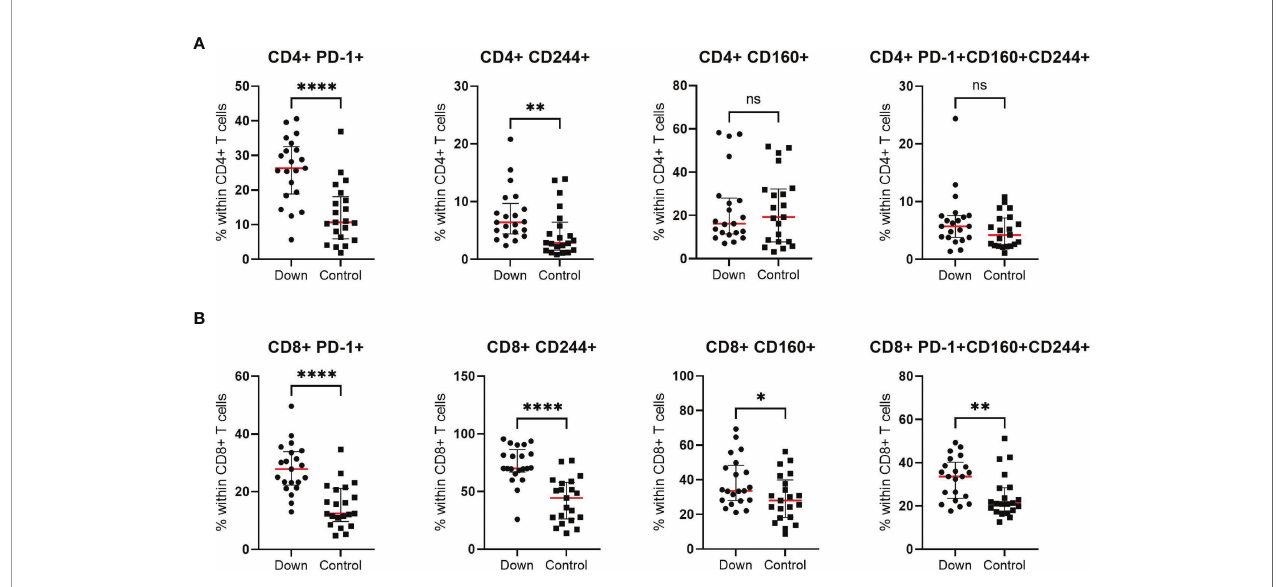
FIGURE 5 | T cell exhaustion of CD4+ and CD8+ cells in 21 children with Down syndrome and 21 healthy age-matched controls. (A) Increased expression of PD-1+ and CD244+ and similar levels of CD160+ and PD-1+CD160+CD244+ co-expression in CD4+ T cells. (B) Elevated levels of all exhaustion markers (PD-1, CD160 and CD244) in CD8+ T cells. Median and interquartile ranges are indicated. *p <0.05; **p < 0.01; ****p < 0.0001; ns p >